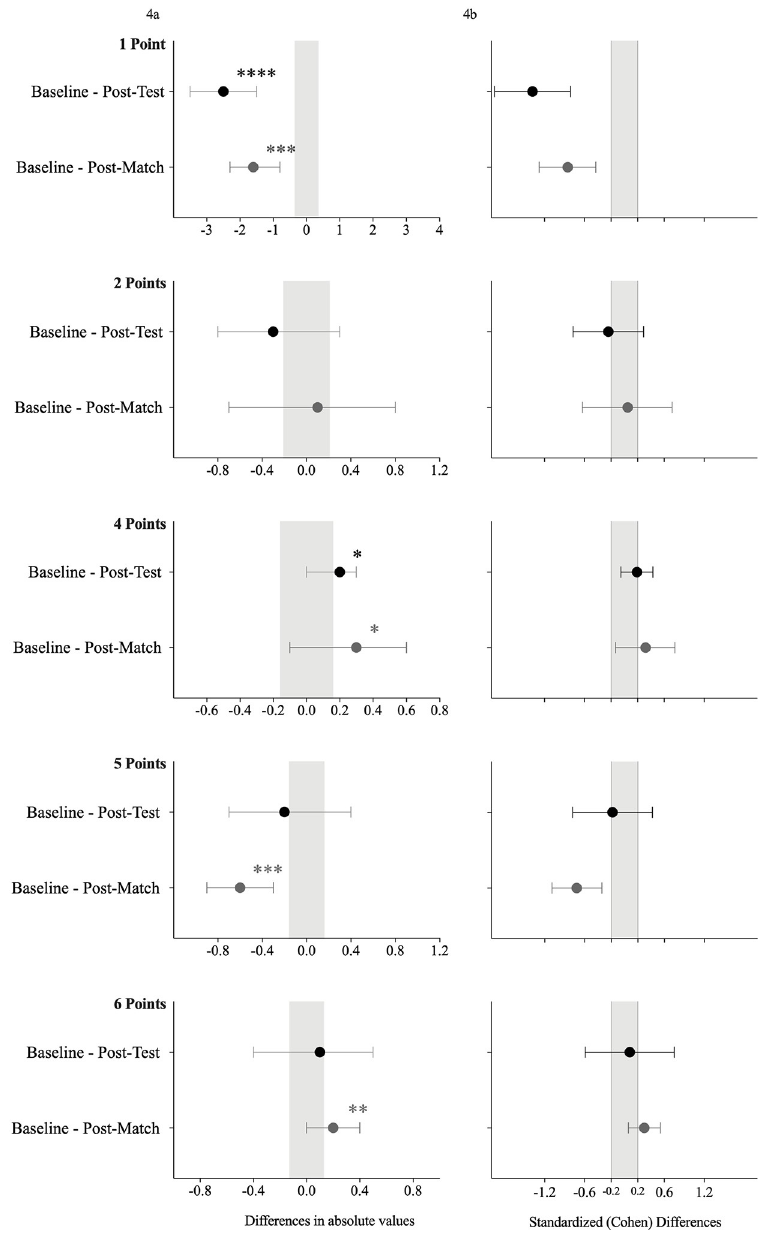
Fig 4. Effects of the traditional intervention and differential learning intervention on the Accuracy according to each zone (a). Gray solid lines indicate individual responses, while black dotted lines indicated group mean value. Also, standardized (Cohen) differences; (b) of variables between the traditional and differential learning groups (black mark represents the comparison between baseline and post-test, while the grey mark represents the comparison between baseline and post-match test). Error bars indicate uncertainty in the true mean changes with 90% confidence intervals. � possibly; �� likely; ��� very likely; ���� most likely.